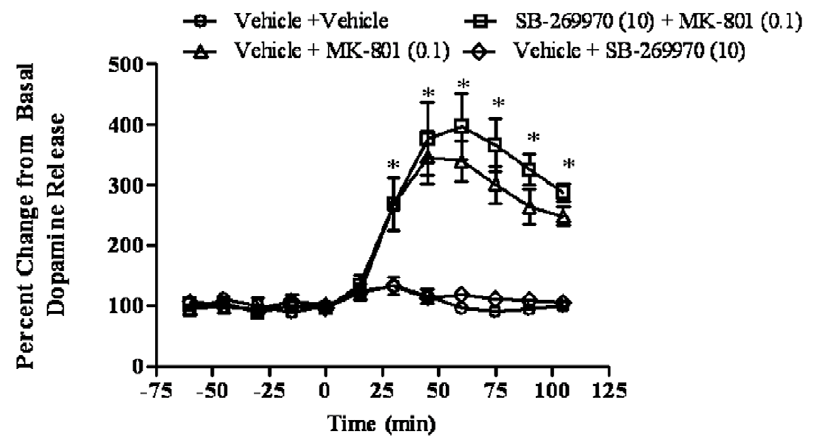
Figure 4. Effects of SB-269970 on MK-801-induced dopamine release. Results are expressed as percentage ofbaseline (mean 6 S.E.M., N=5- 6 per group). SB-269970 (10 mg/kg) did not affect dopamine levels by itself, nor did it alter the effect of MK-801 (0.1 mg/kg) on dopamine levels. *p , 0.001, at each time point compared to control.